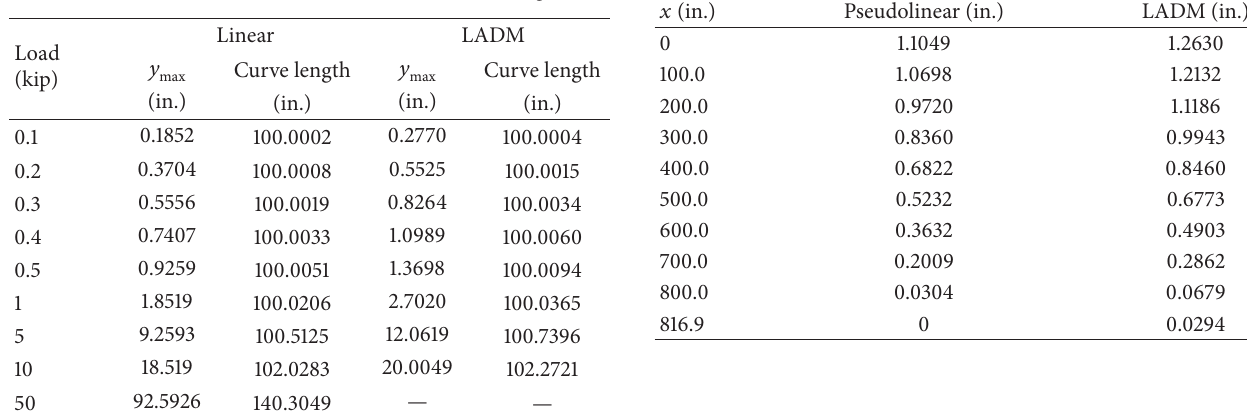
Figure 2: Small deflection curve. Table 1: Numerical results under various load testing.